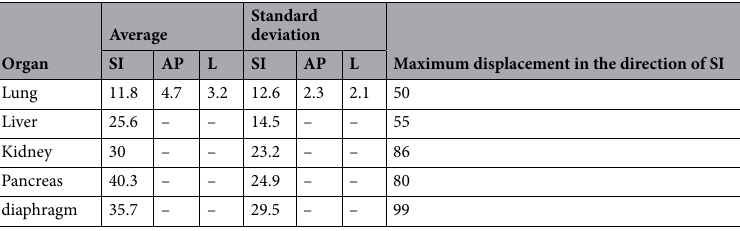
Table 3. Displacement (mm). SI Superior–inferior, AP Anterior–posterior, L